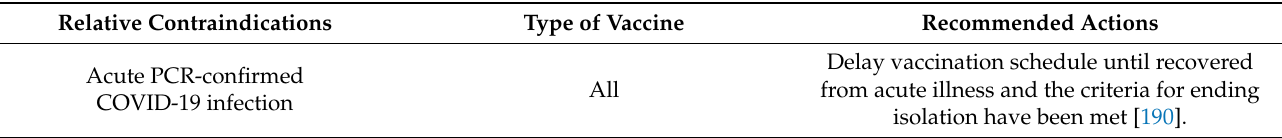
Table 3. Common relative contraindications of vaccinations reported in the literature and in guidelines. NACI: National Advisory Committee on Immunization; USCDC: United States Centre for Disease Control and Prevention; VITT: vaccine- induced immune thrombotic